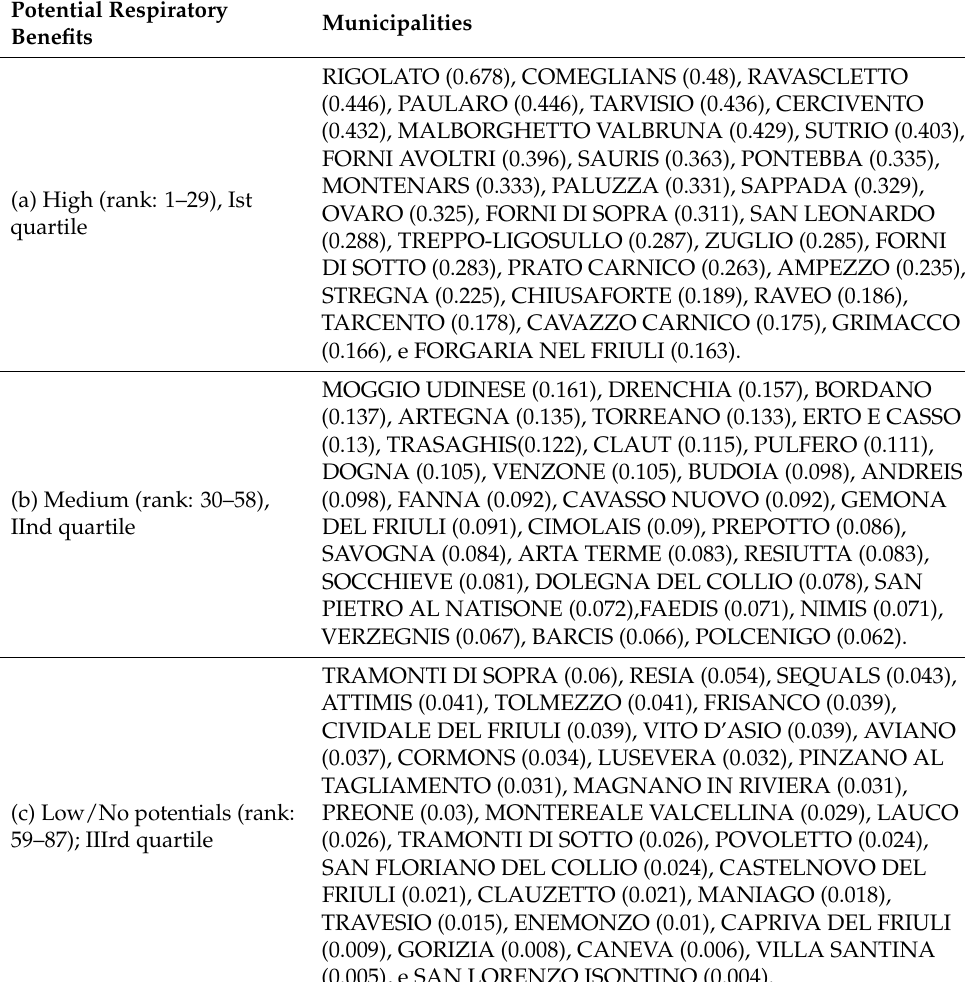
Table 4. Potential respiratory benefits of forest heritage by